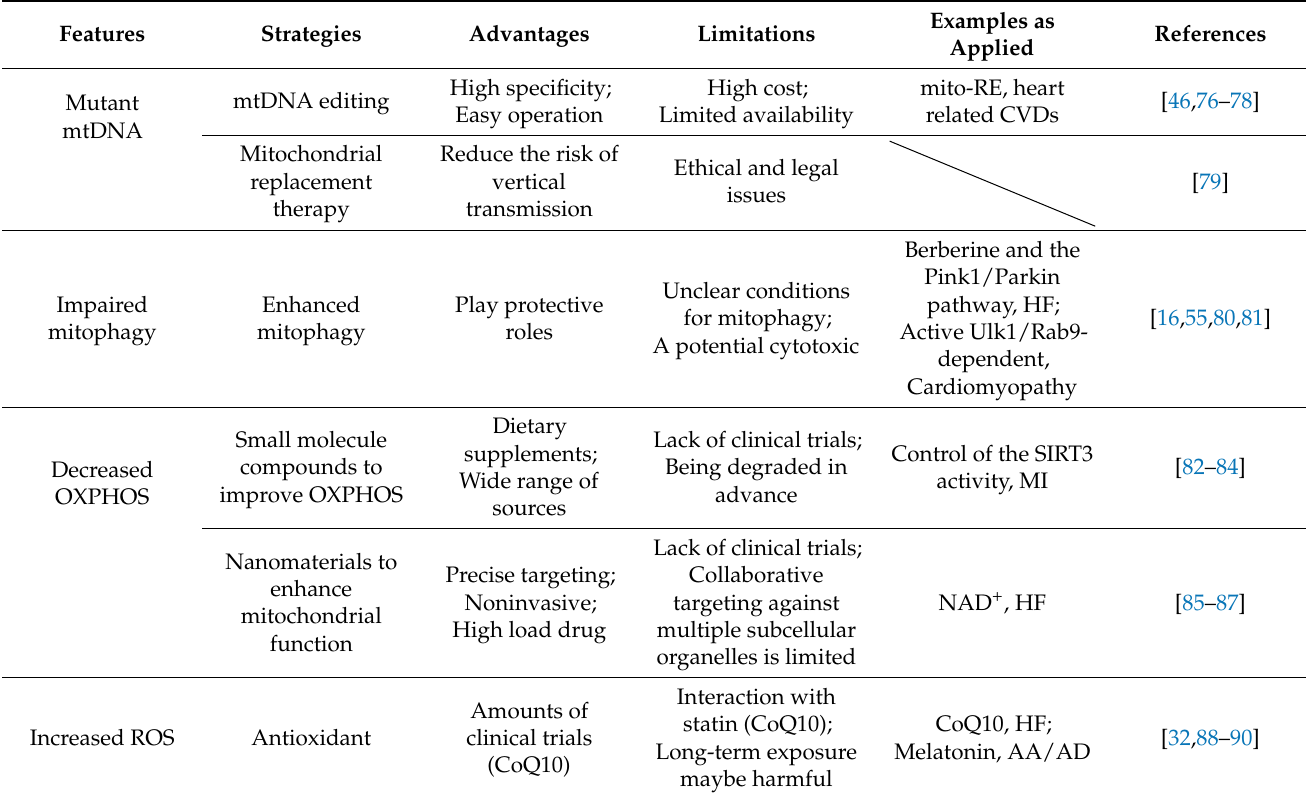
Table 2. Advantages and limitations of treatment strategies for targeting mitochondria to treat